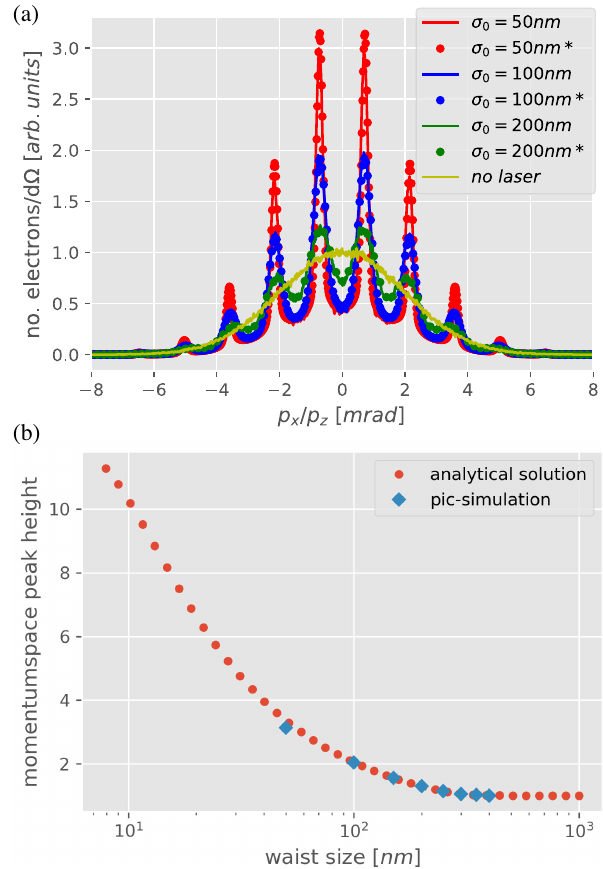
FIG. 7. (a) Transverse momentum space of electron beams with different σ x ( σ x 0 ¼ 2 mrad, σ z ¼ 2 μ m, γ e ¼ 100 and d ¼ 0 . 8 μ m) after interaction. The solid line indicates the PIC simulation results and the dashed the solution of Eq. (5) assuming a sinusoidal electrical laser field. (b) Normalized peak height of modulation in transverse momentum space after laser-electron interaction calculated with Eq. (5). No interaction results in a height of